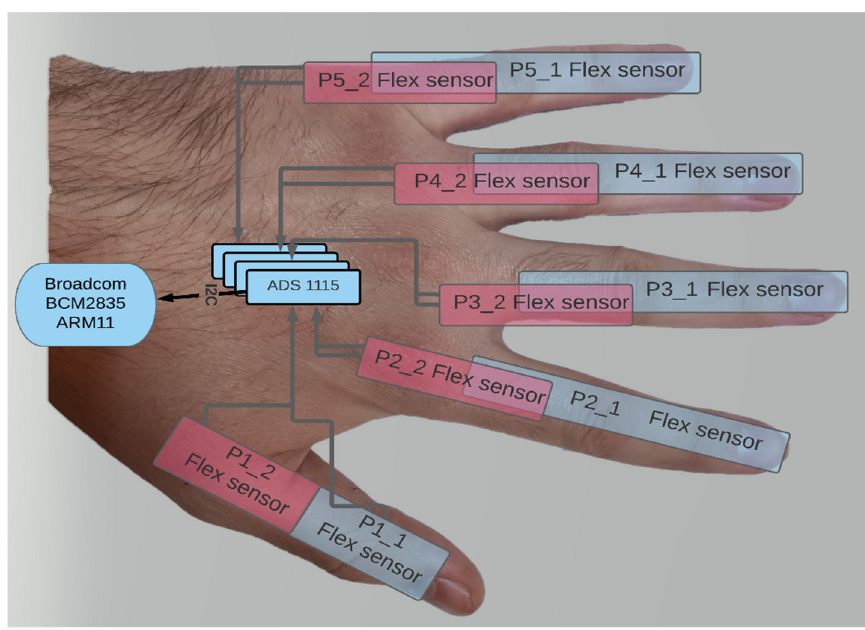
Figure 3. Block diagram of the